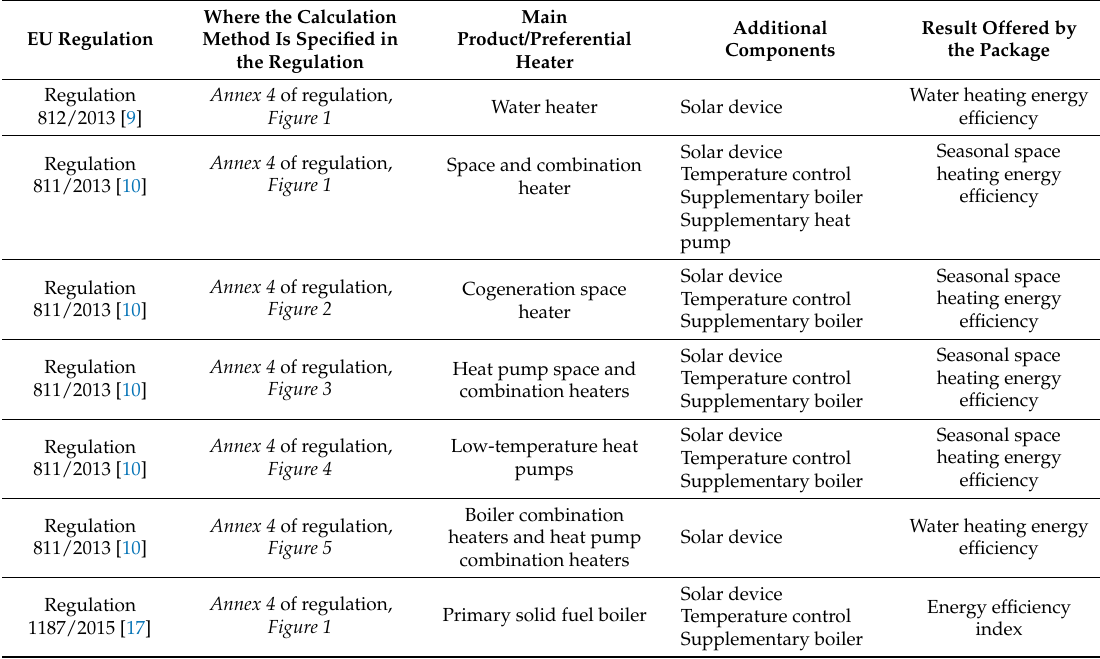
Table 1. Overview of the efficiency package calculation schemes in EU